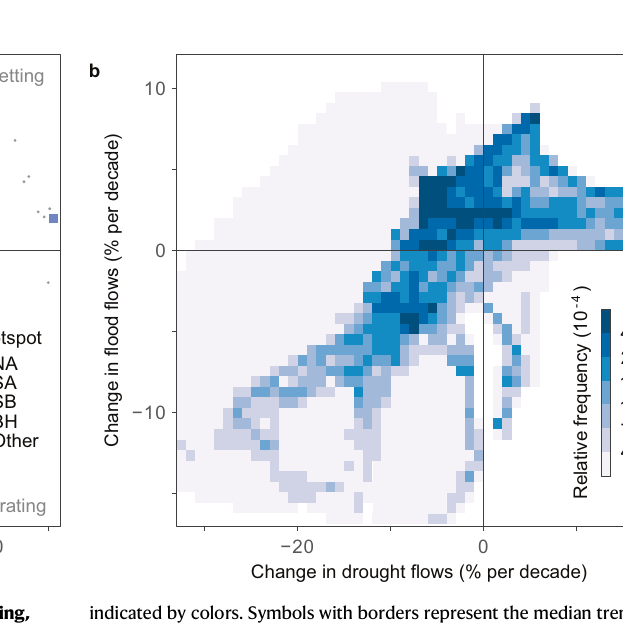
indicated by colors. Symbols with borders represent the median trend of each hotspot, and the error bars indicate the median temporal uncertainty of the trend estimates. b Classi fi cation of regional trends, with darker colors indicating higher areal fraction per